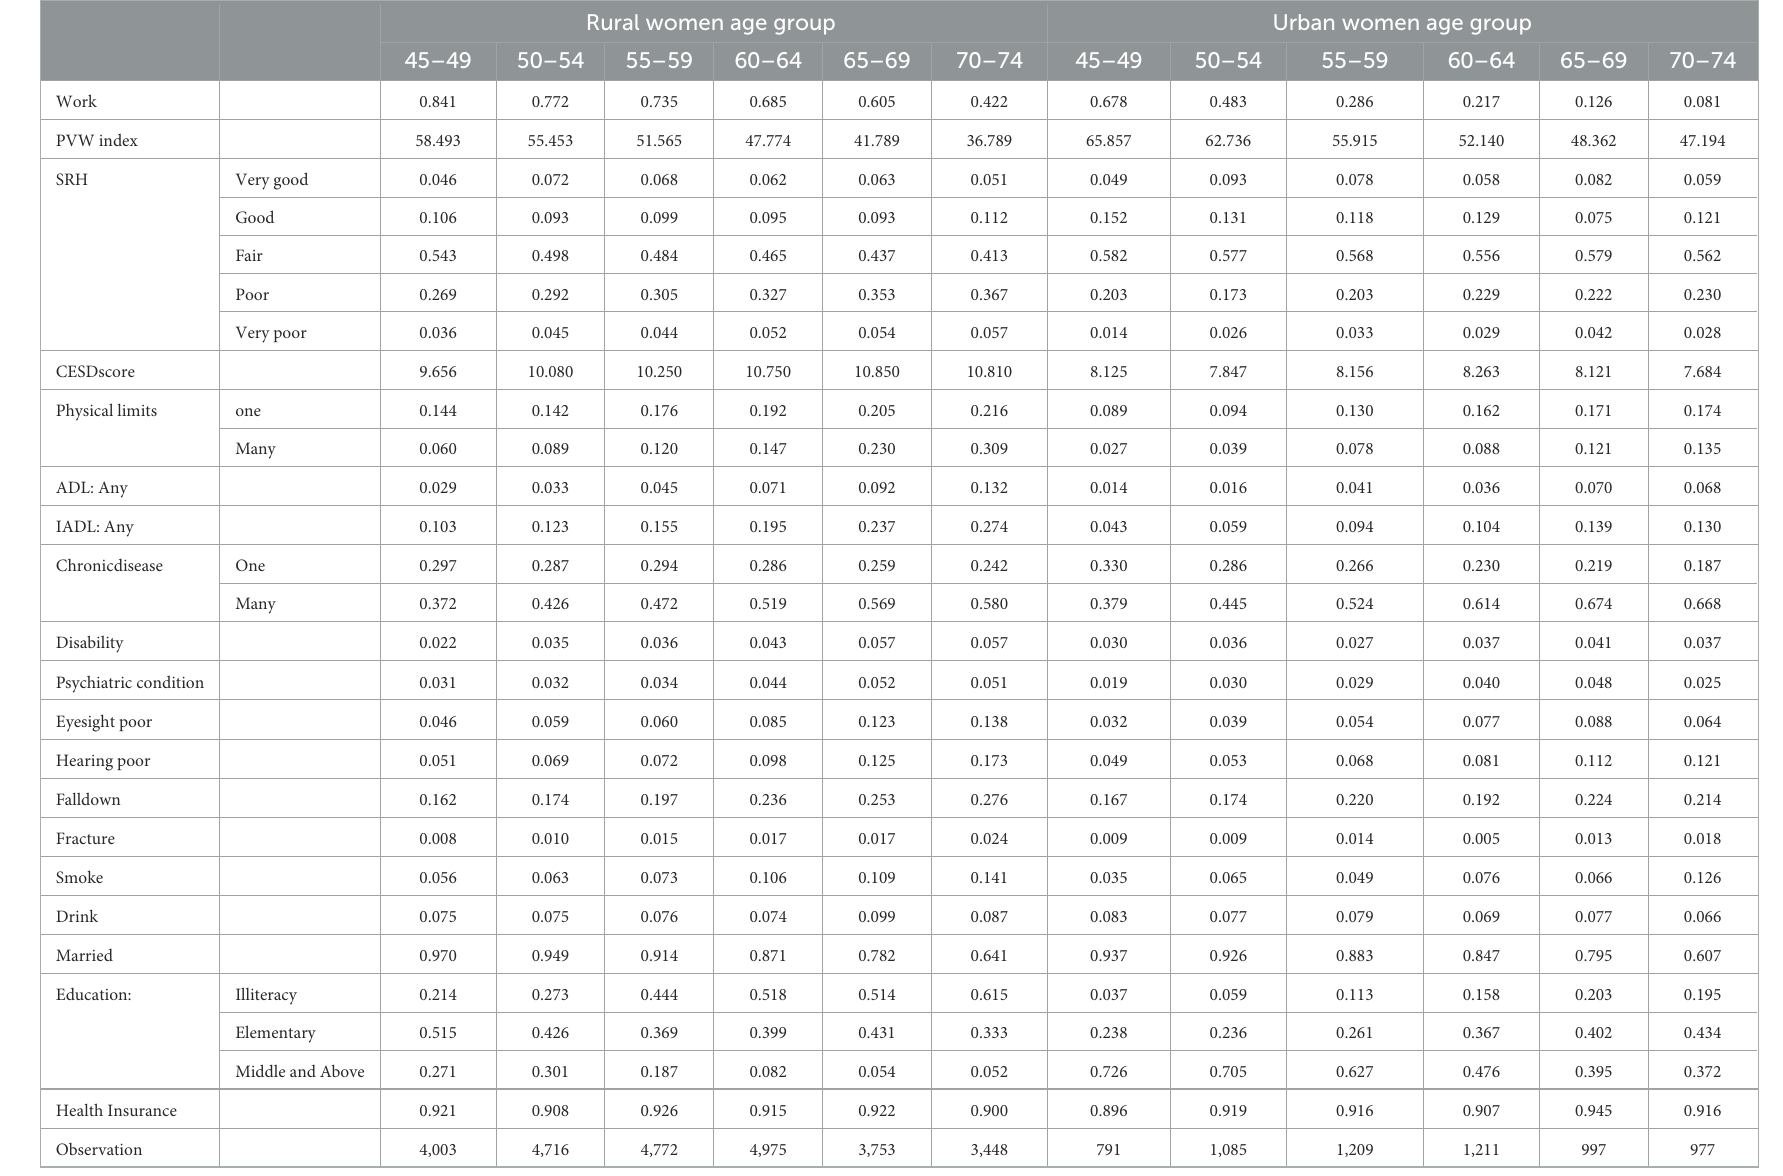
TABLE 1 Labor participation rates, individual characteristics and prevalence of disease by age